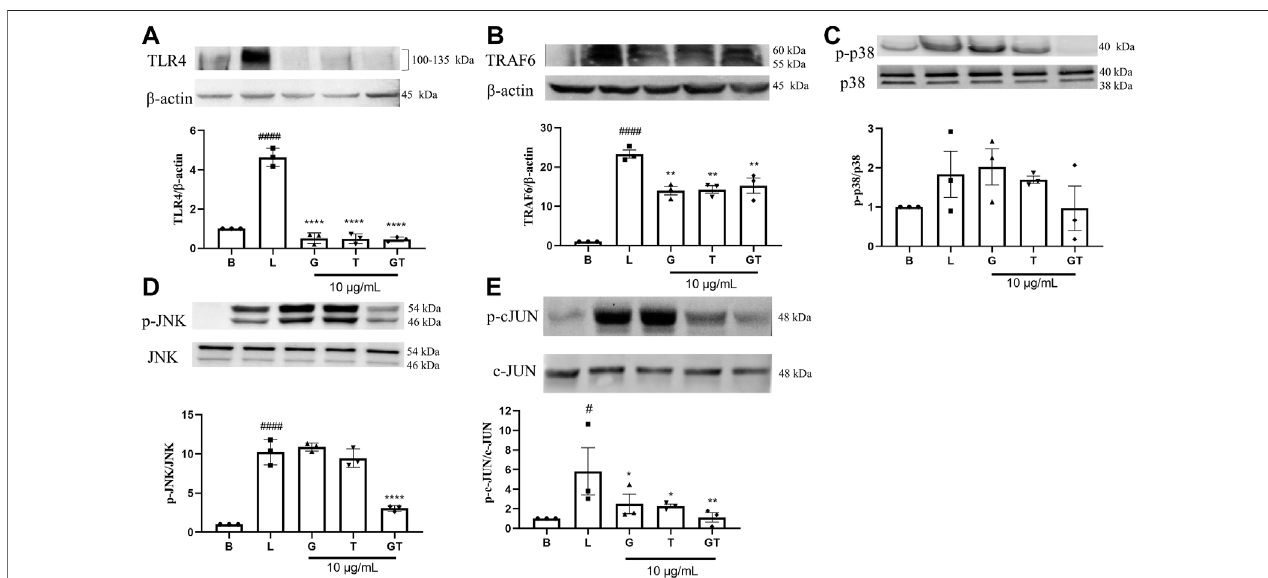
FIGURE 4 | Down-regulatory effects of G, T and GT on the key protein targets in the TLR4-TRAF6-MAPK pathway. Cells were cultured in T75 cell fl asks and were pretreated withG,TorGT1 hprior toLPS(100 ng/ml)forvarious optimal time points. Proteinexpression levels ofTLR4 (A) ,TRAF-6 (B) ,p-p38 (C) ,p-JNK (D) ,p-cJUN (E) wereanalyzedbywesternblotusingwholeproteinextract.Allresults( n =3)areexpressedasthemean±SEM,# p < 0.05vs.B;#### p < 0.0001vs.Blank (B) .* p < 0.05, ** p < 0.01 vs. LPS